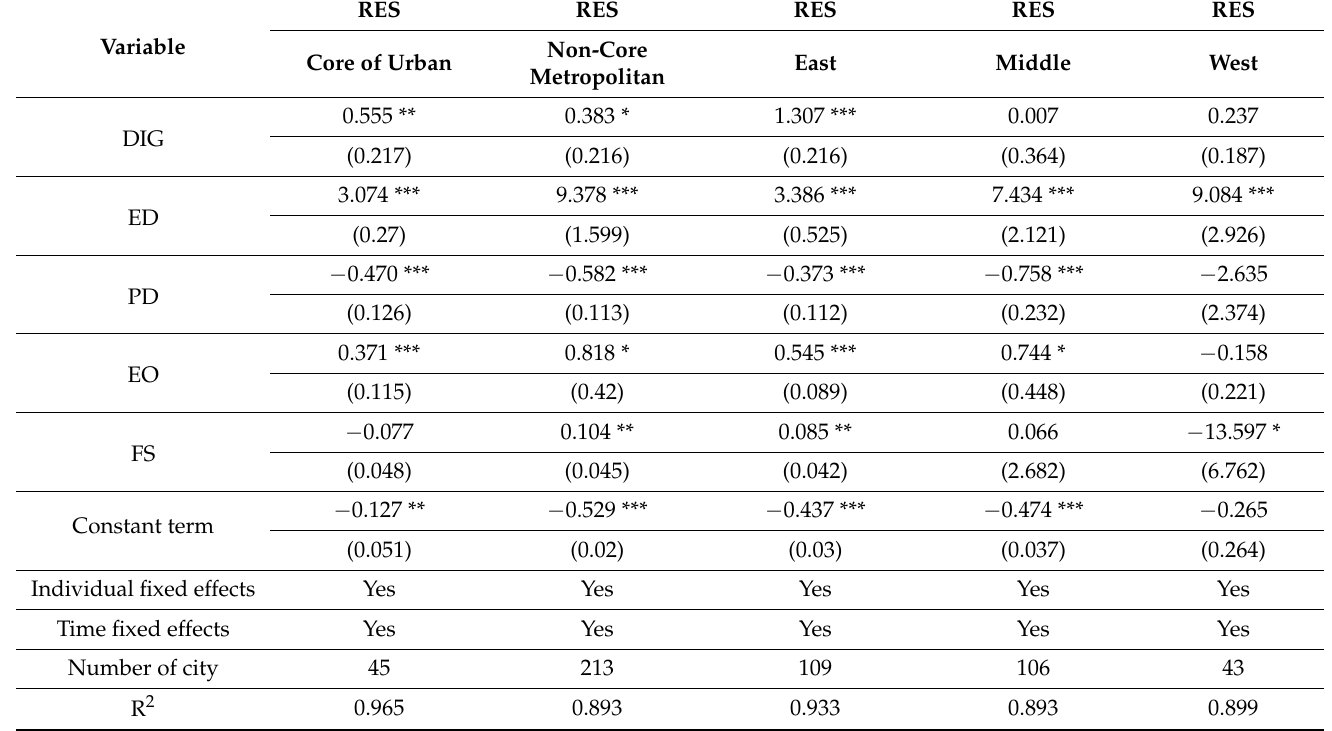
Table 4. Heterogeneity